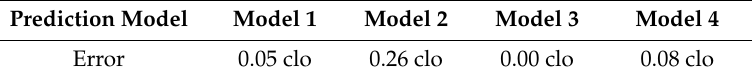
Figure 8. Results of the prediction models. Table 4. Errors of the prediction models.